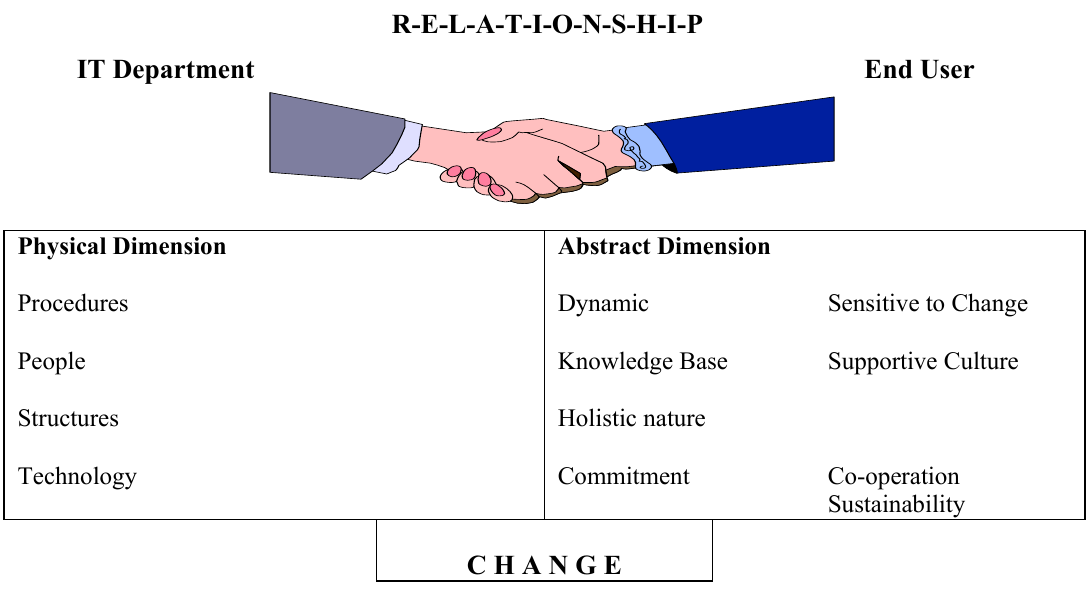
Figure 1: The basic components of an IT-end user relationship (Leonard, 2002) End user